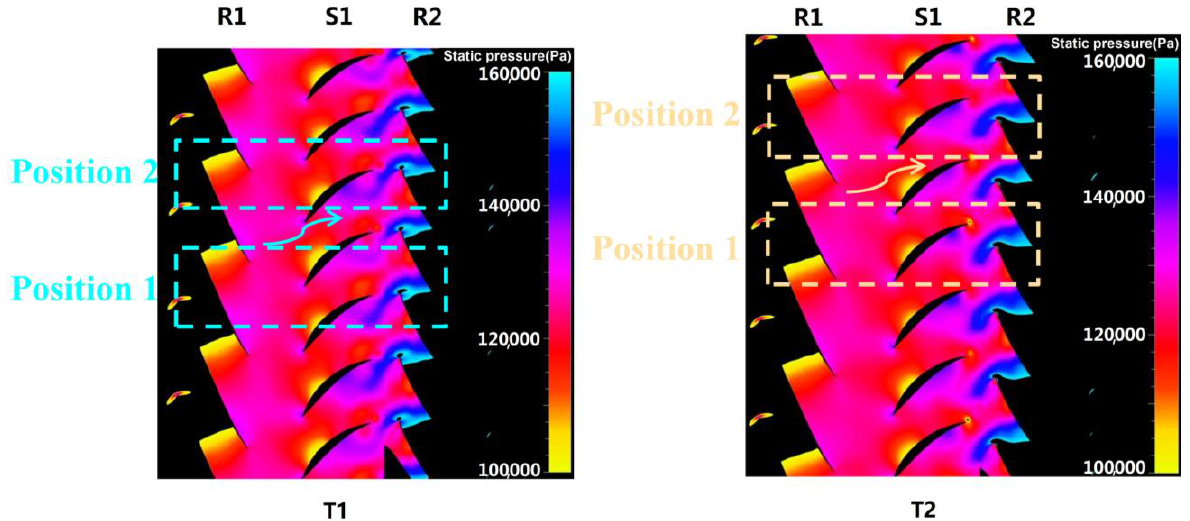
Figure 19 . The effects of the relative position between the R1 and R2 . Figure 19. The effects of the relative position between the R1 and